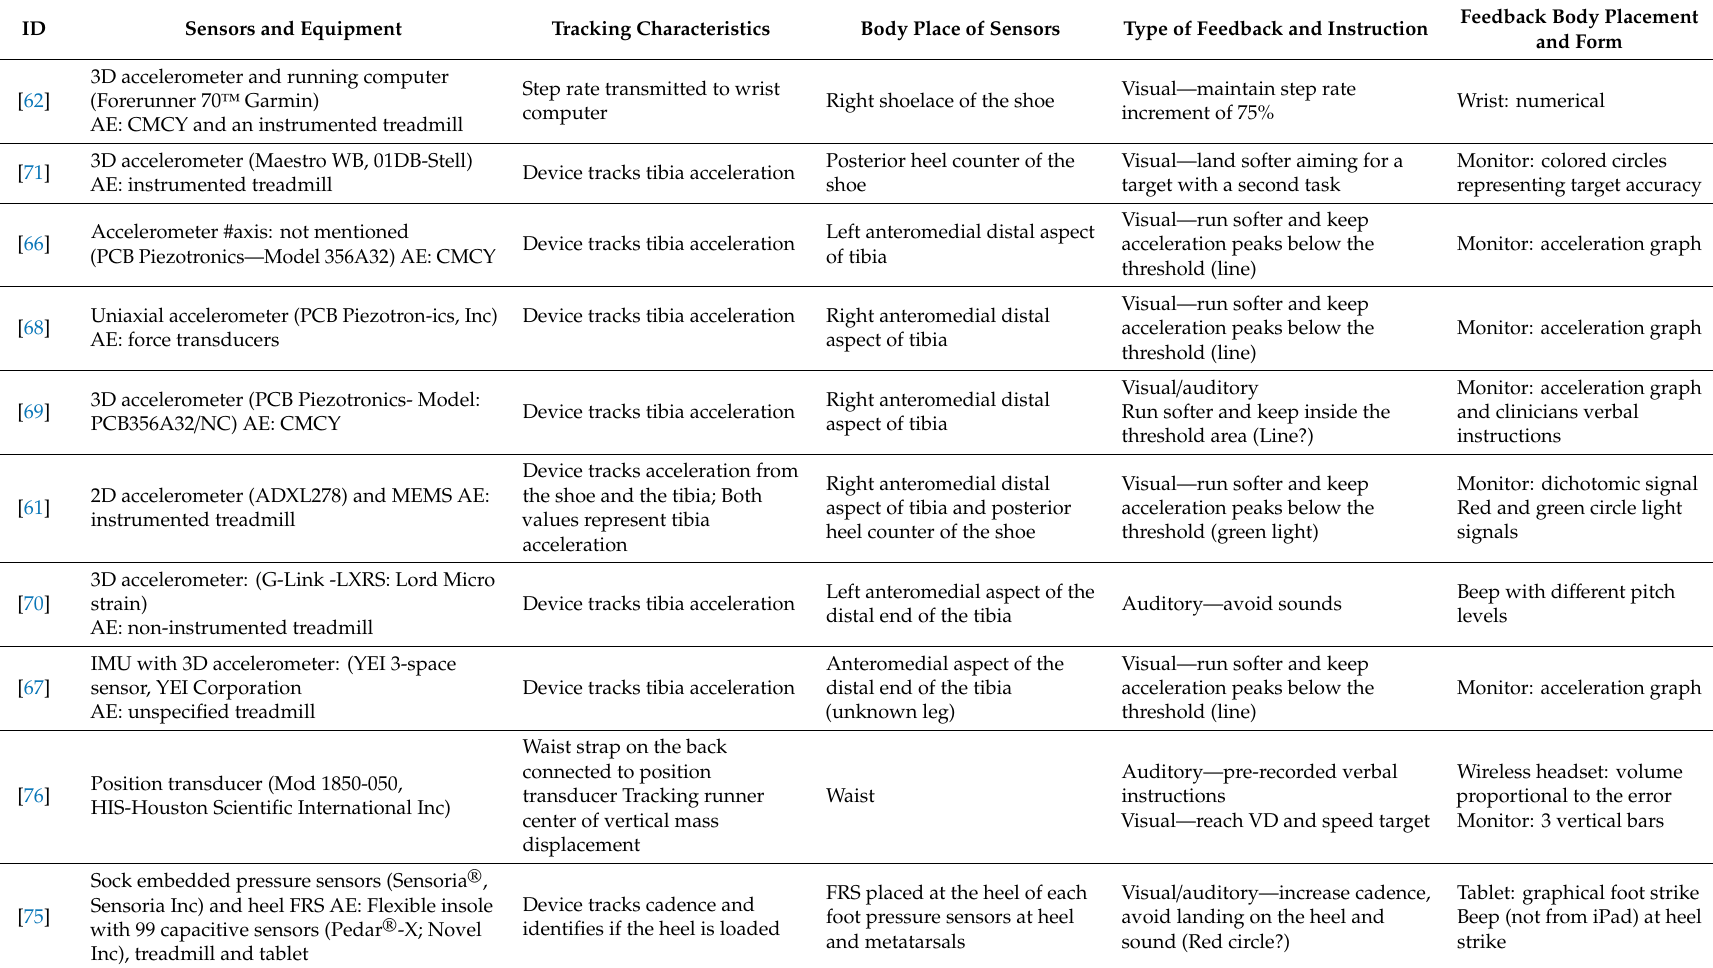
Table 3. Equipment, body placement and feedback